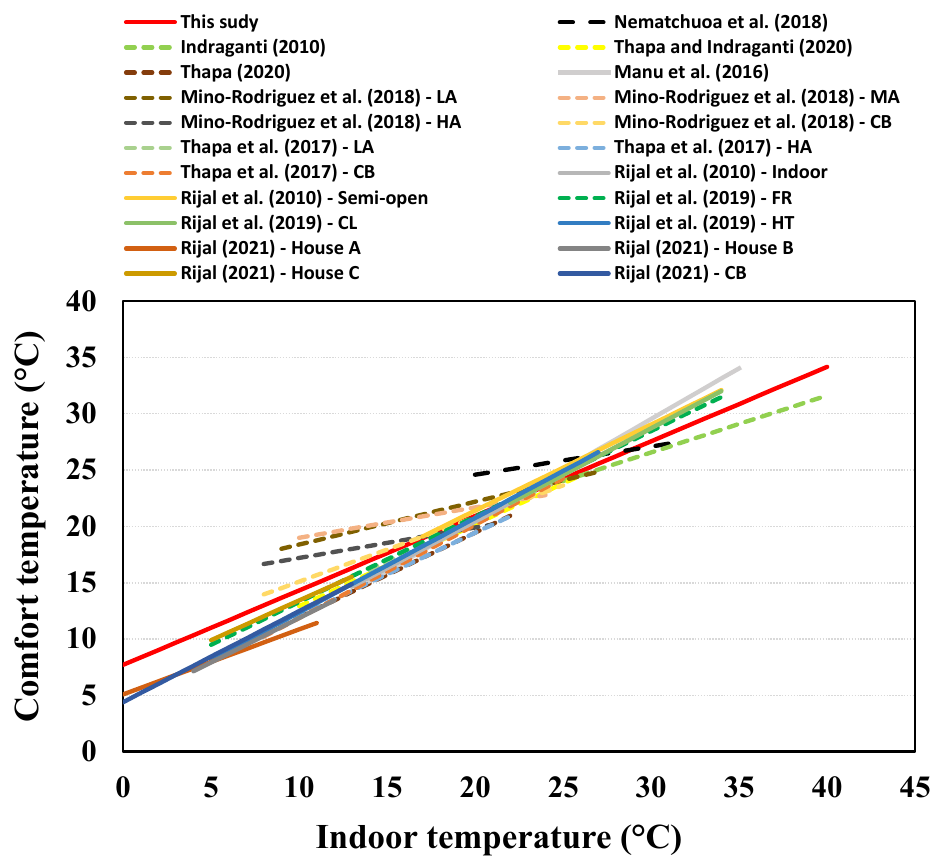
Figure 8. Regression line for comfort temperature with indoor temperature ranges [26,30,31,33,37– 39,43,76,77].